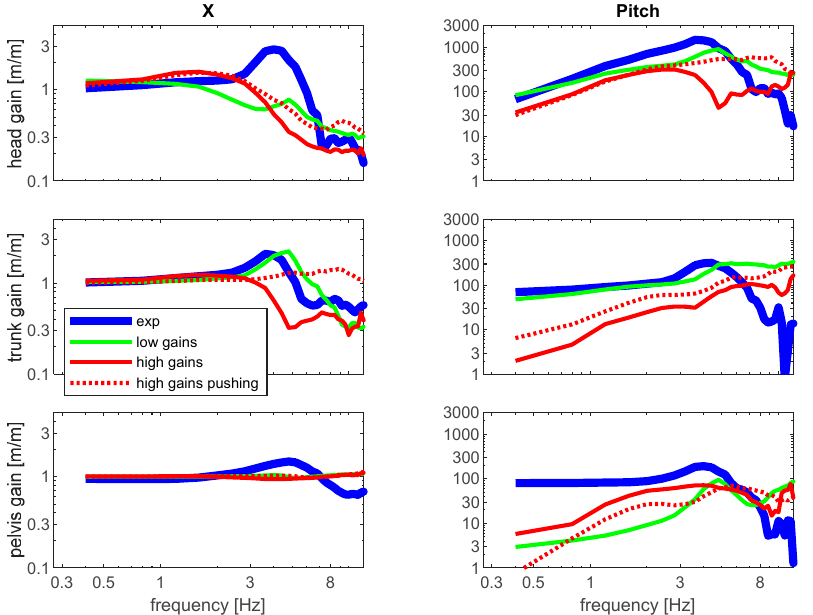
Figure 4. Fore–aft vibration validation. Model prediction of head ( upper ), trunk ( middle ) and pelvis ( lower ) in translation ( left ) and pitch rotation ( right ). Blue line: experimental; solid green line: best model with low postural gains; red solid line: high gains fitted towards the slalom but no pushing; red dotted line: high gains and with hips and knees pushing the body into the seat back.